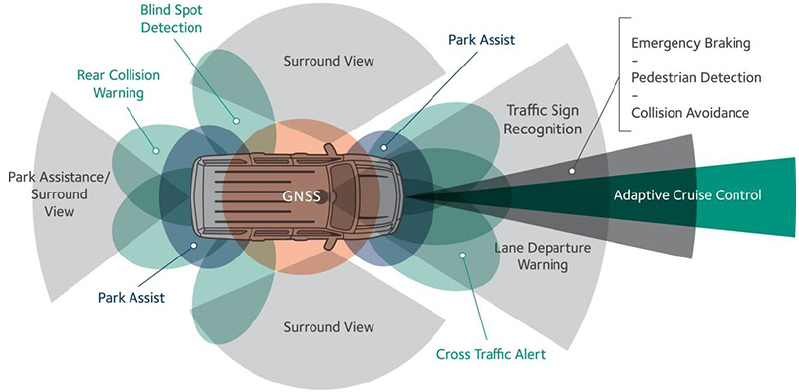
Figure 2. Different types of distance sensors in intelligent vehicles. Table 2. Possible distance-measuring technologies that are used in vehicular systems. Data in this table is compiled from